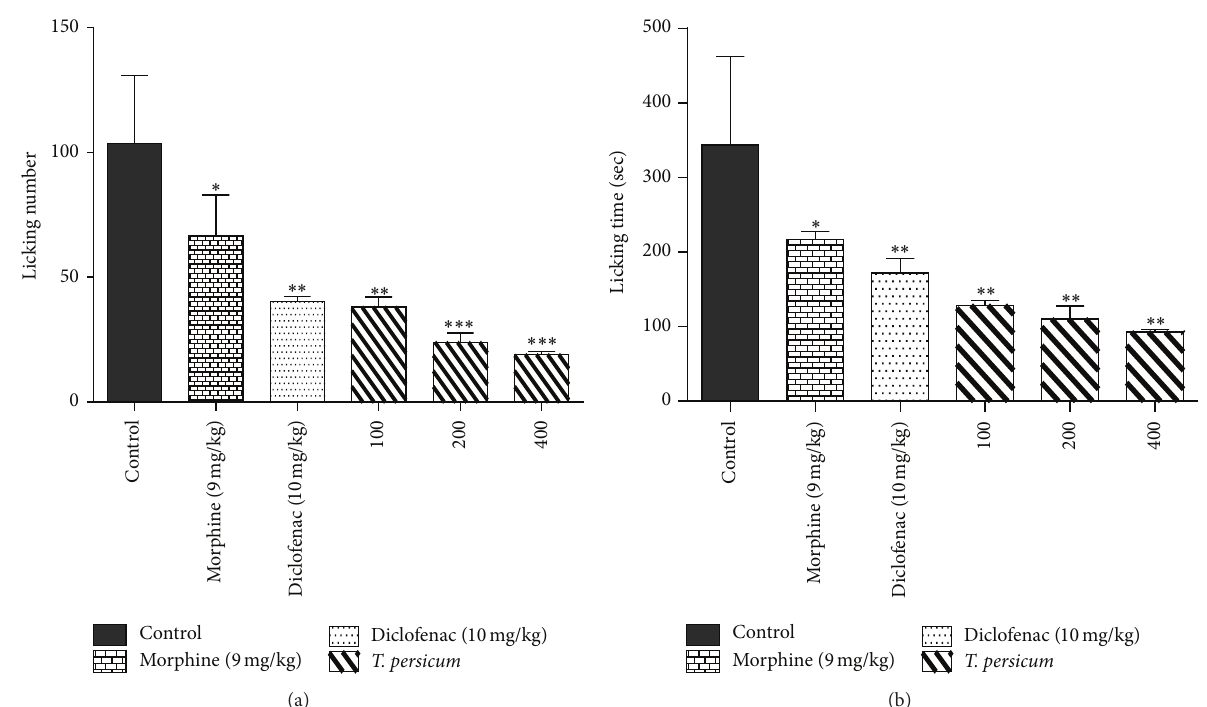
Figure 2: Effects of TPE, Morphine (9mg/kg), and Diclofenac (10mg/kg) in the chronic phase of the formalin test in mice by assessing the number of lickings (a) and the licking time (b). ∗ 𝑃 < 0.05 , ∗∗ 𝑃 < 0.01 , and ∗∗∗ 𝑃 < 0.001 significantly different from the control animals. Each value represents the mean ± SEM ( 𝑛 = 8 ).